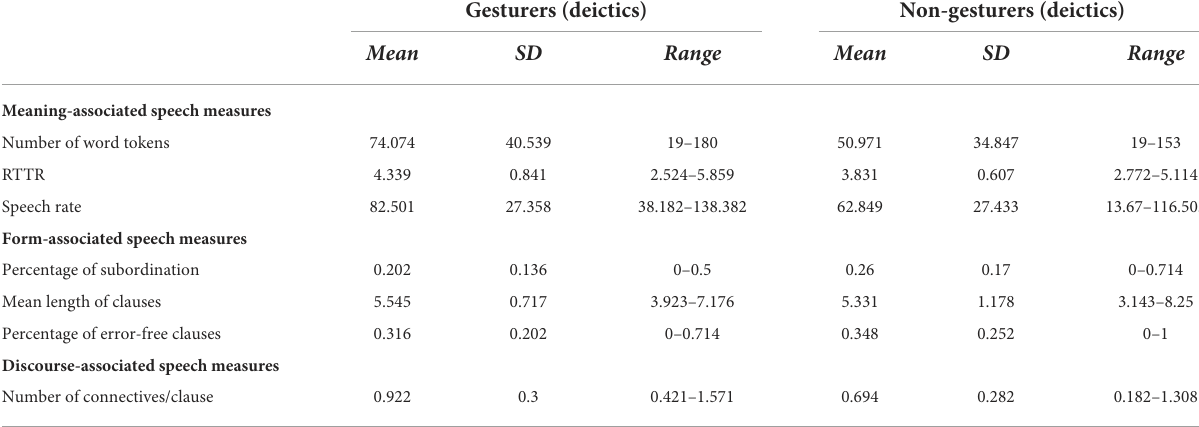
TABLE 7 Descriptive statistics of speech measures for gesturers and non-gesturers of